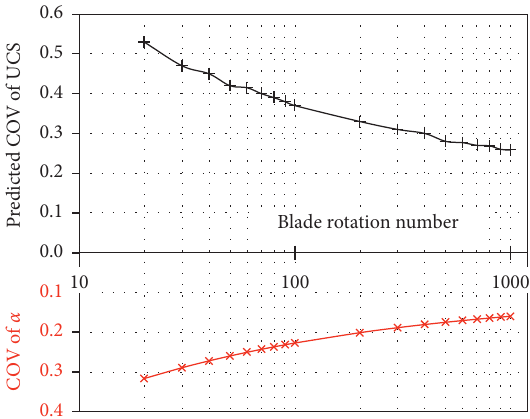
Figure 9: Prediction of coefficient of variation (COV) in unconfined compressive strength (UCS). Table 3: Statistical and deterministic results of unconfined compressive strength. Binder concentration ( α ) Unconfined compressive strength ( q u